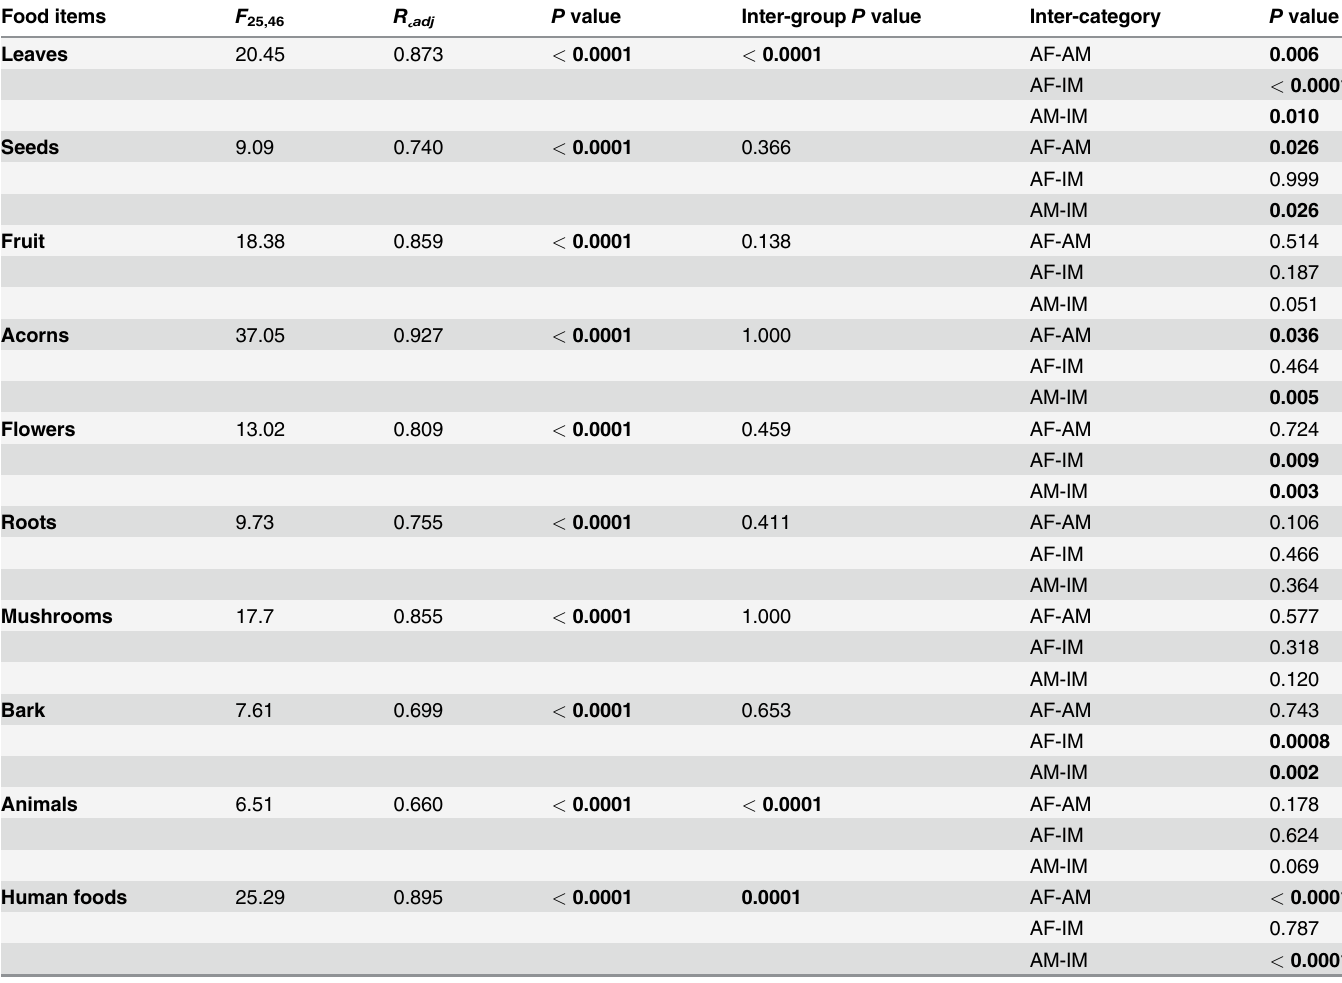
Table 2. Statistical analysis of monthly, inter-group and inter-age-sex category variations in the macaques ’ diets. Food items